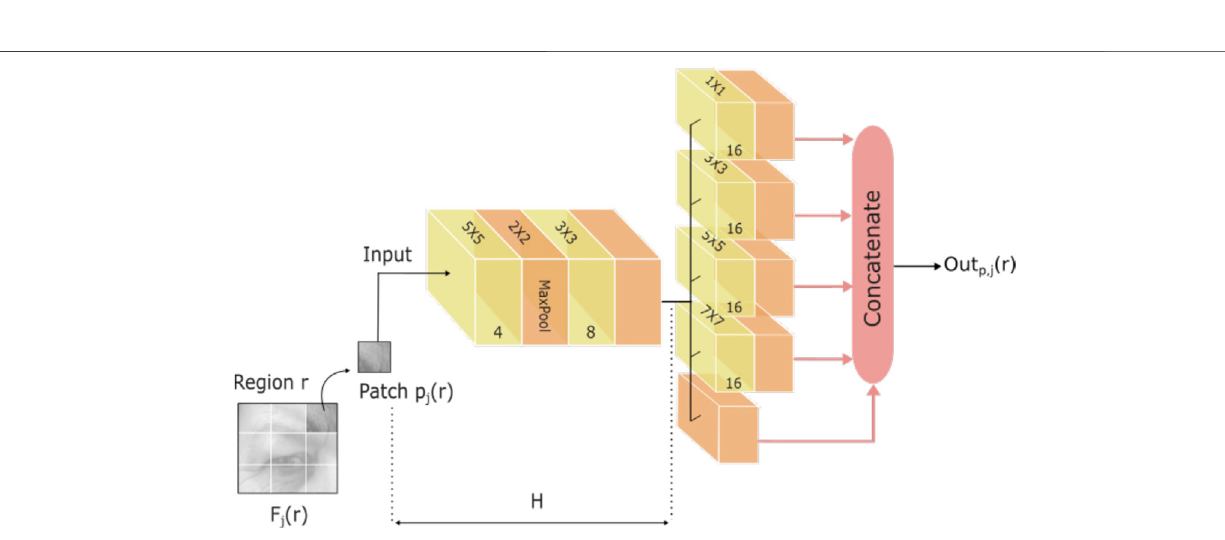
FIGURE 4 | The CNN architecture proposed by Aouayeb et al. (2019). It is employed to extract very local features form patches.